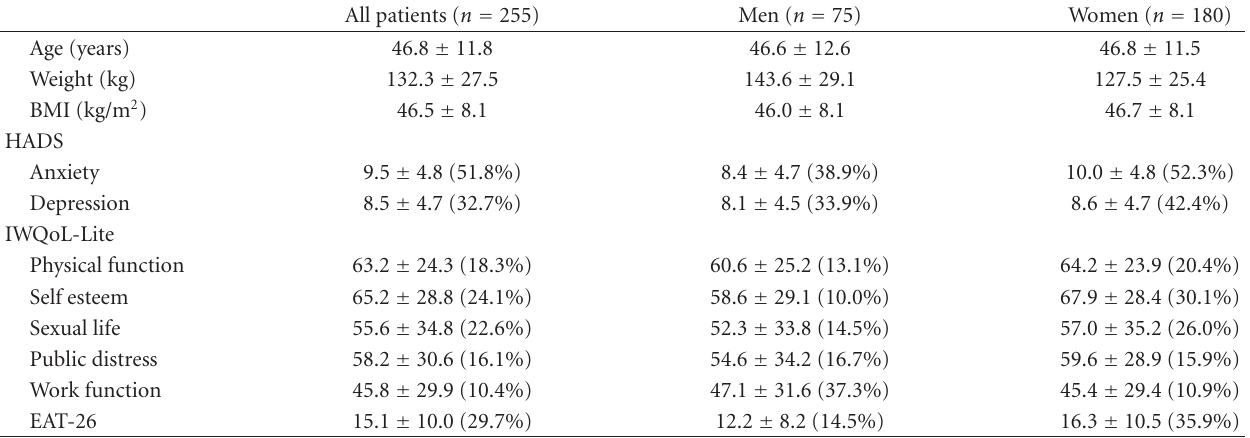
Table 1: Baseline results (mean ± sd) and proportion (%) of patients with psychosocial disorders.